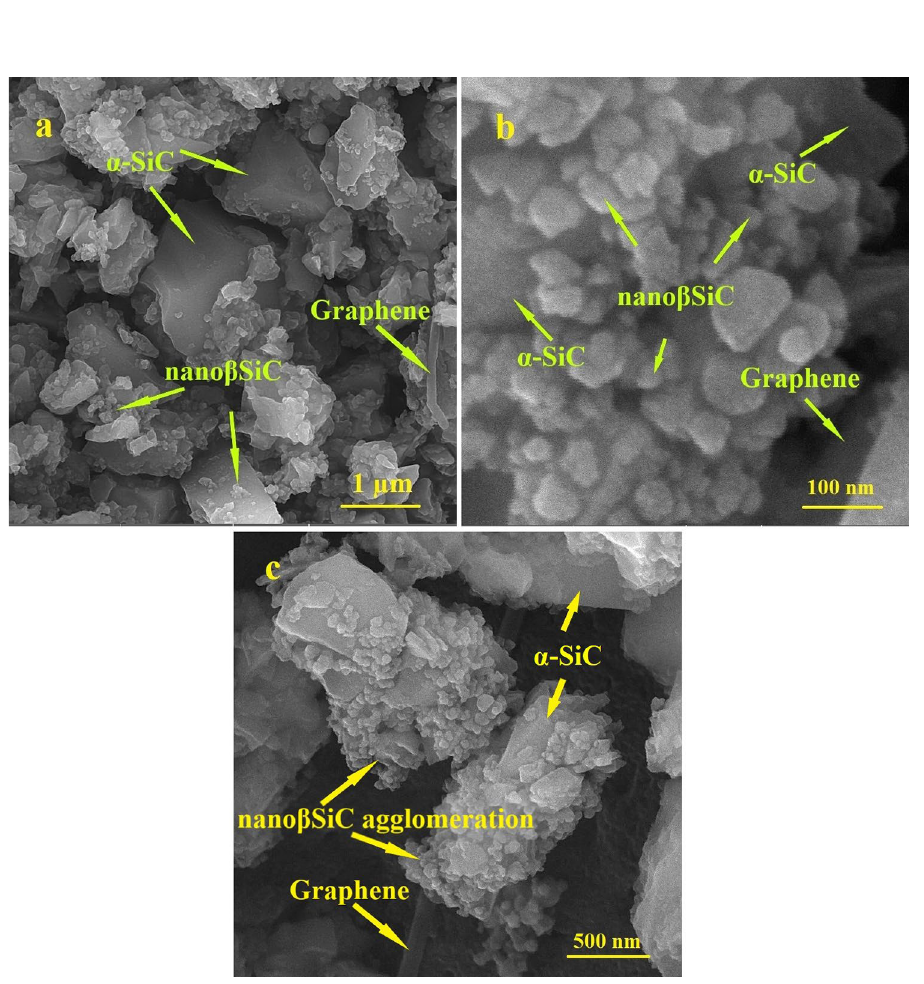
Figure 1. FESEM images of samples ( a , b ) 5B1G in two magnifications and ( c ) 15B3G after 3 hours of